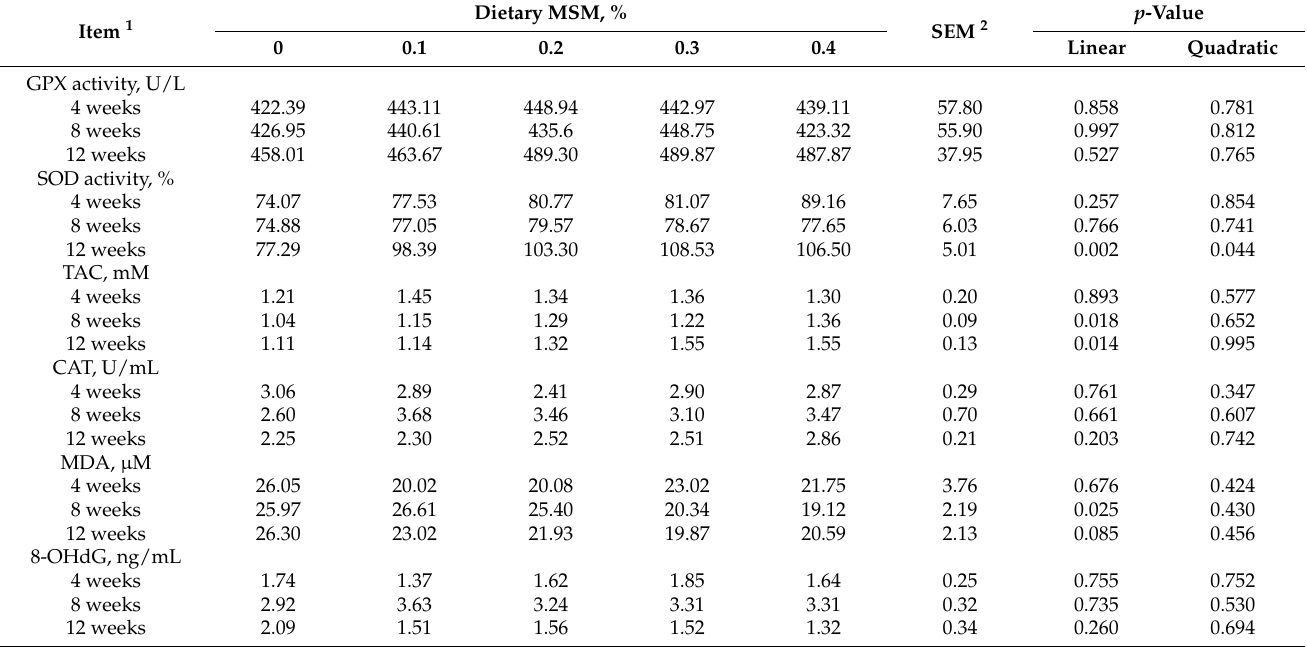
Table 5. Effects of graded levels of dietary methyl sulfonyl methane on the serum markers of oxidative stress in laying